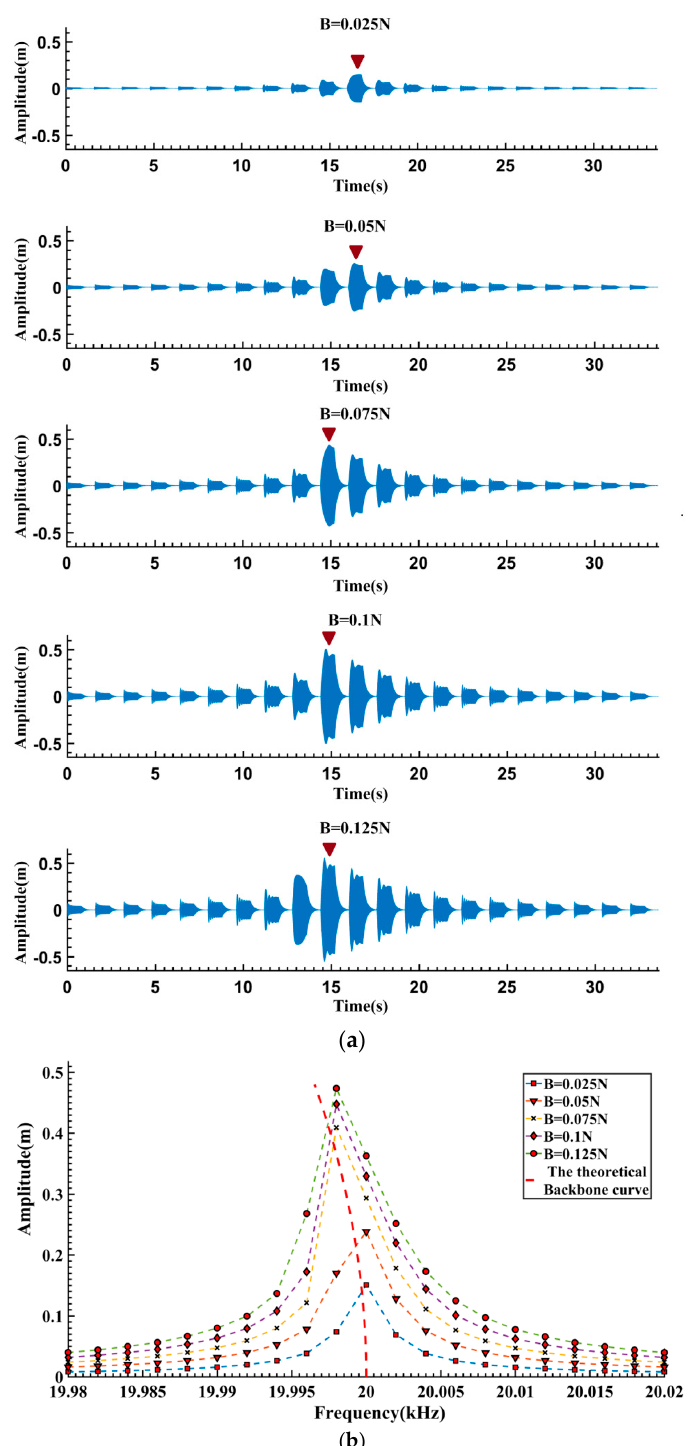
Figure 2. System response signals and amplitude-frequency curves corresponding to different excitation: ( a ) System response signals; ( b ) Amplitude-frequency curves. The free vibration signal x ( t ) is truncated from the largest response segment (marked by in